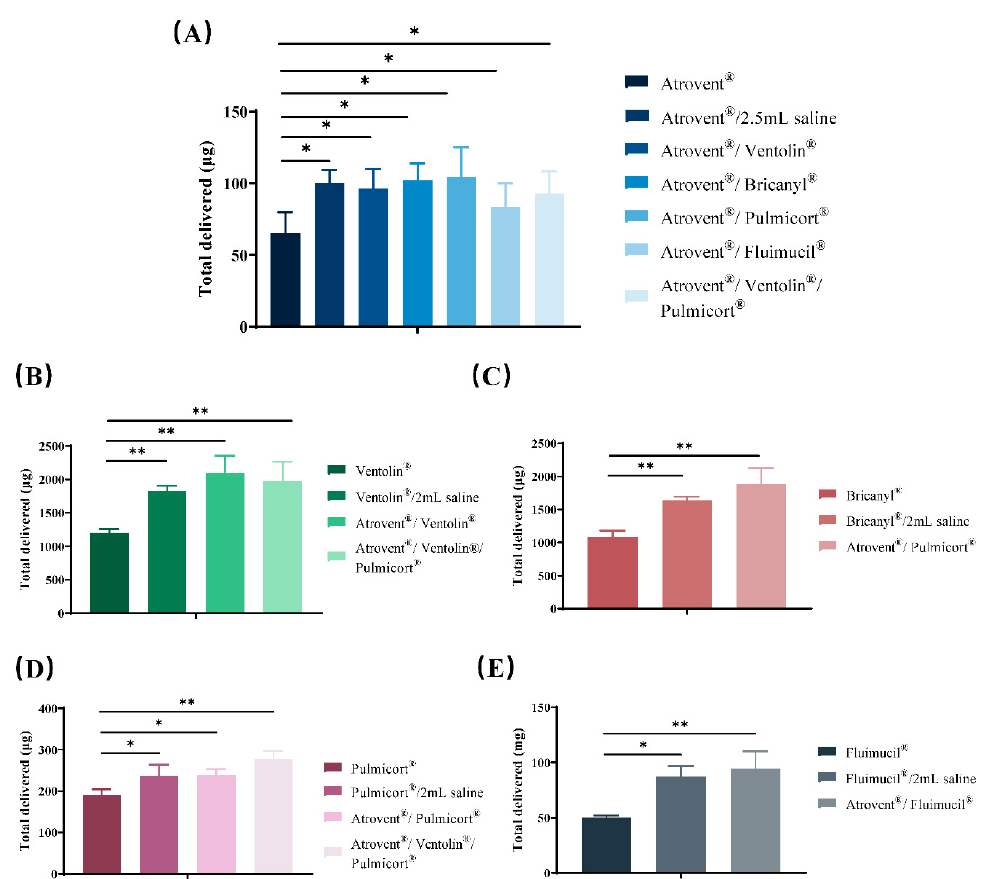
Figure 7. Total active drug delivered of ipratropium bromide ( A ), salbutamol sulfate ( B ), terbutaline sulfate ( C ), budesonide ( D ), and NAC ( E ) in admixtures or single-drug preparations. Results are shown as mean ± standard deviation ( n = 5). * and ** indicate p < 0.05 and p < 0.01 by ANOVA.